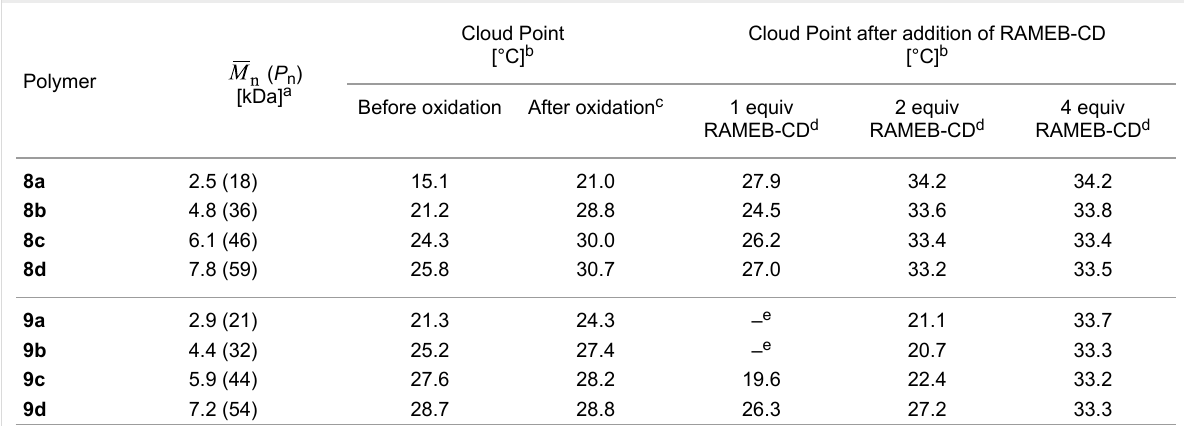
Table 2: Cloud points of the different polymers ( 8a–d and 9a–d ): Influence of RAMEB-CD and oxidation with H 2 O 2 .